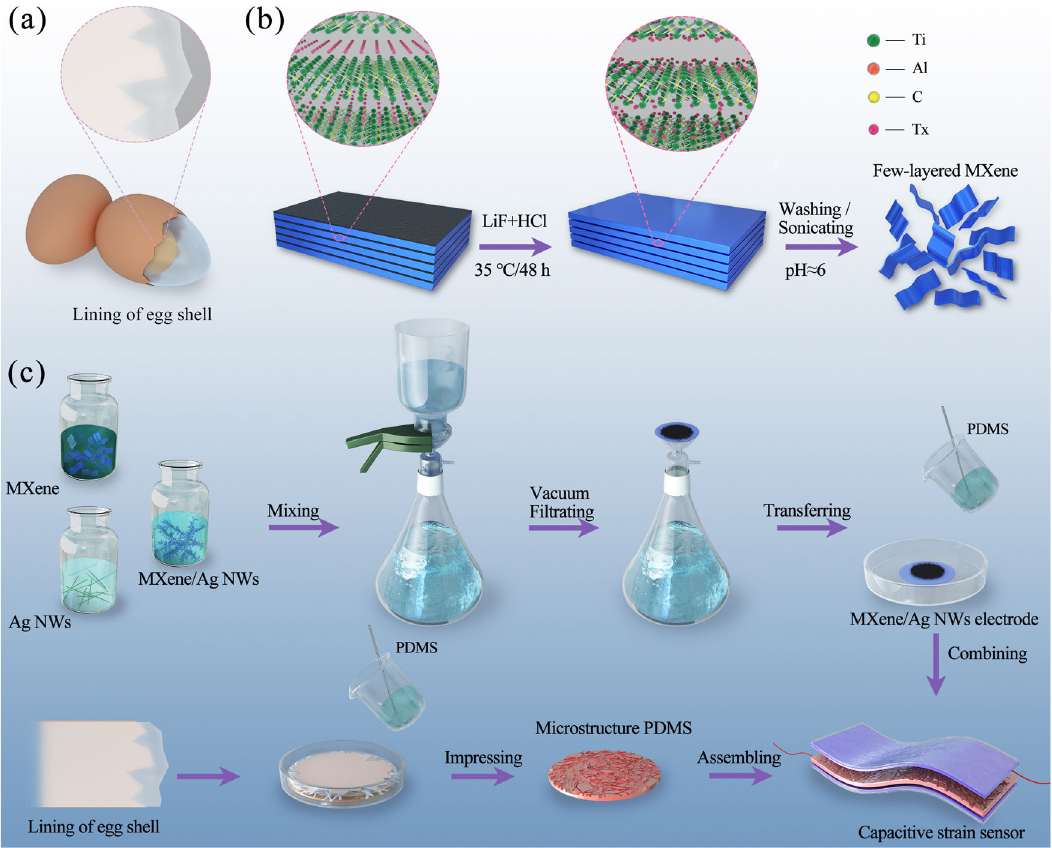
Fig. 1 Fabrication of the capacitive pressure sensor. a Structure illustration of the ESIM; b Schematic presentation of the fabrication process of MXene sheets; c Fabrication process of fl exible capacitive pressure